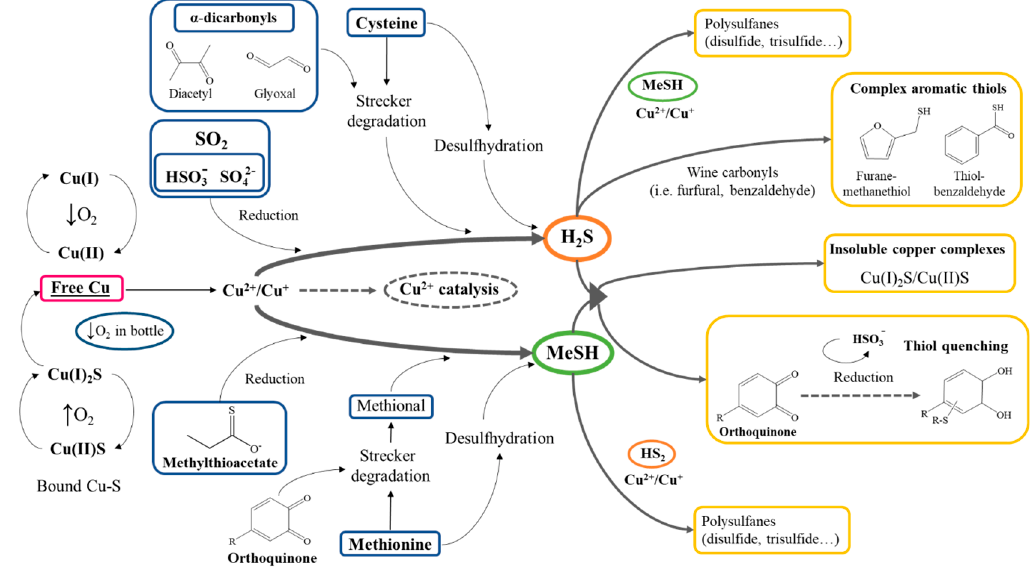
Figure 4. Formation and fate of SH 2 and MeSH involving copper catalysis. Unknown precursors are not shown in the diagram. Adapted [73,157].